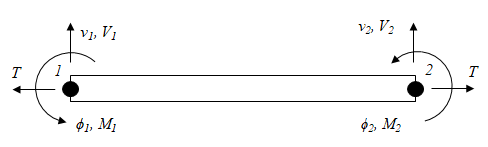
Figure 4. Euler-Bernoulli beam under axial